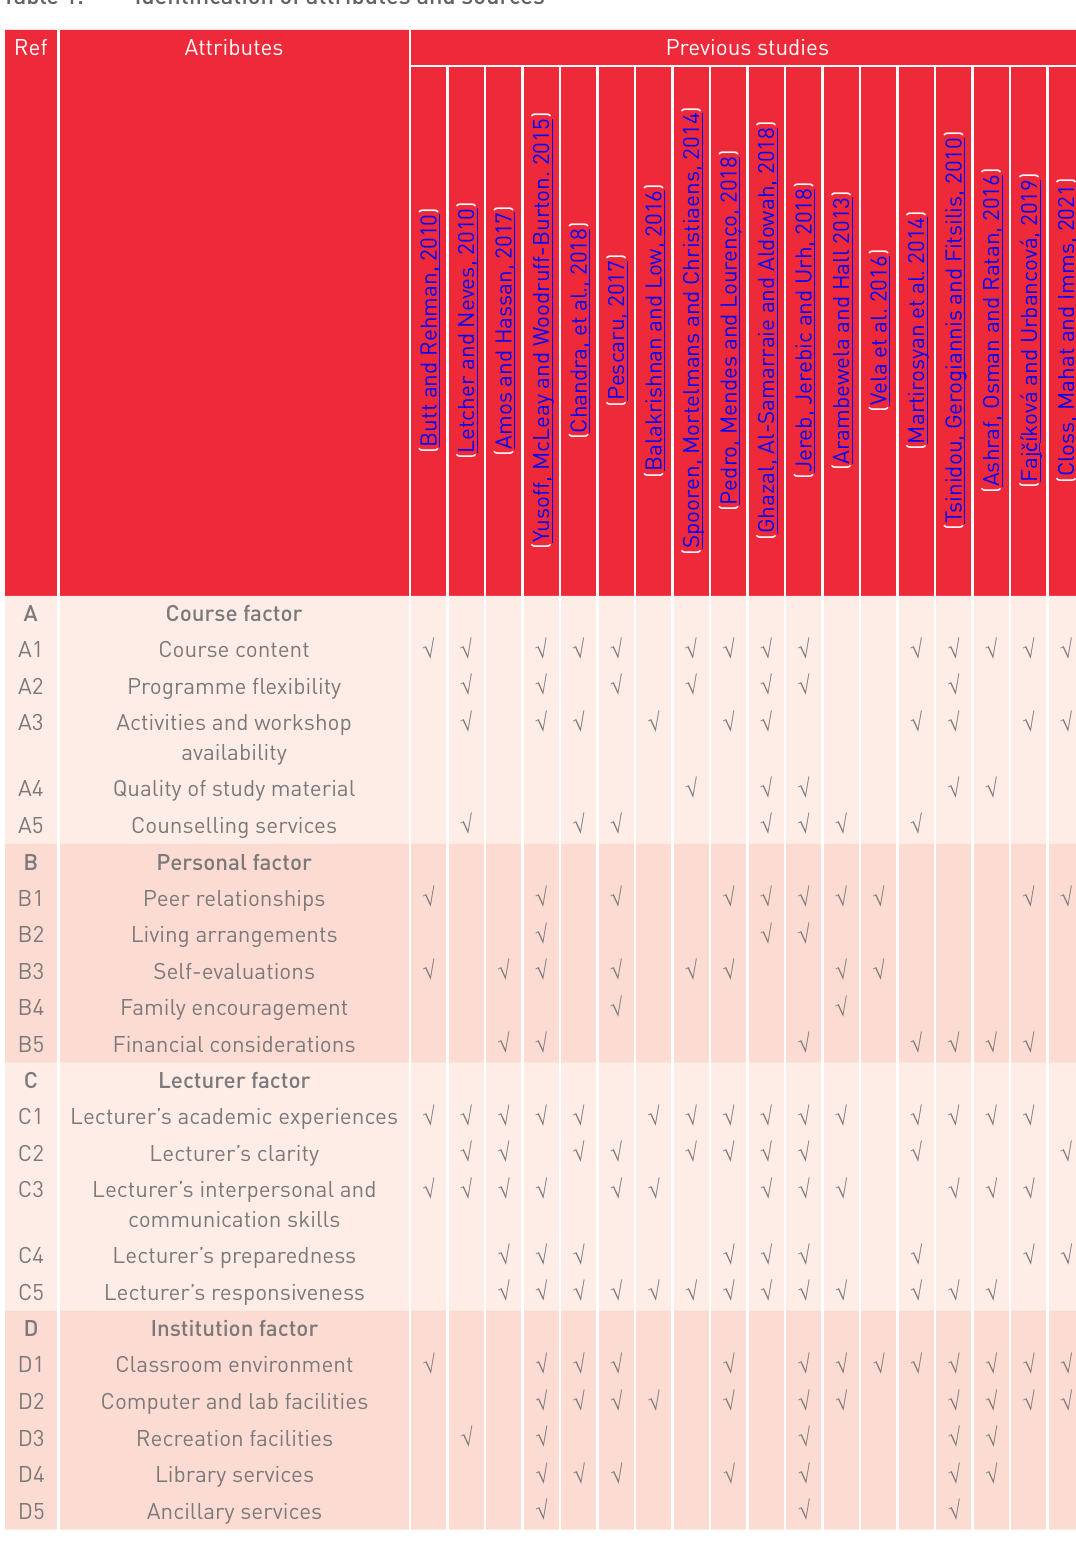
Table 1. Identification of attributes and